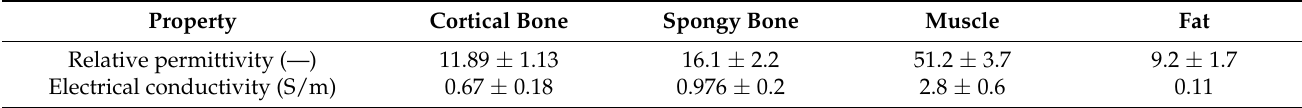
Table 6. Dielectric properties measured in the characterization of the tissue